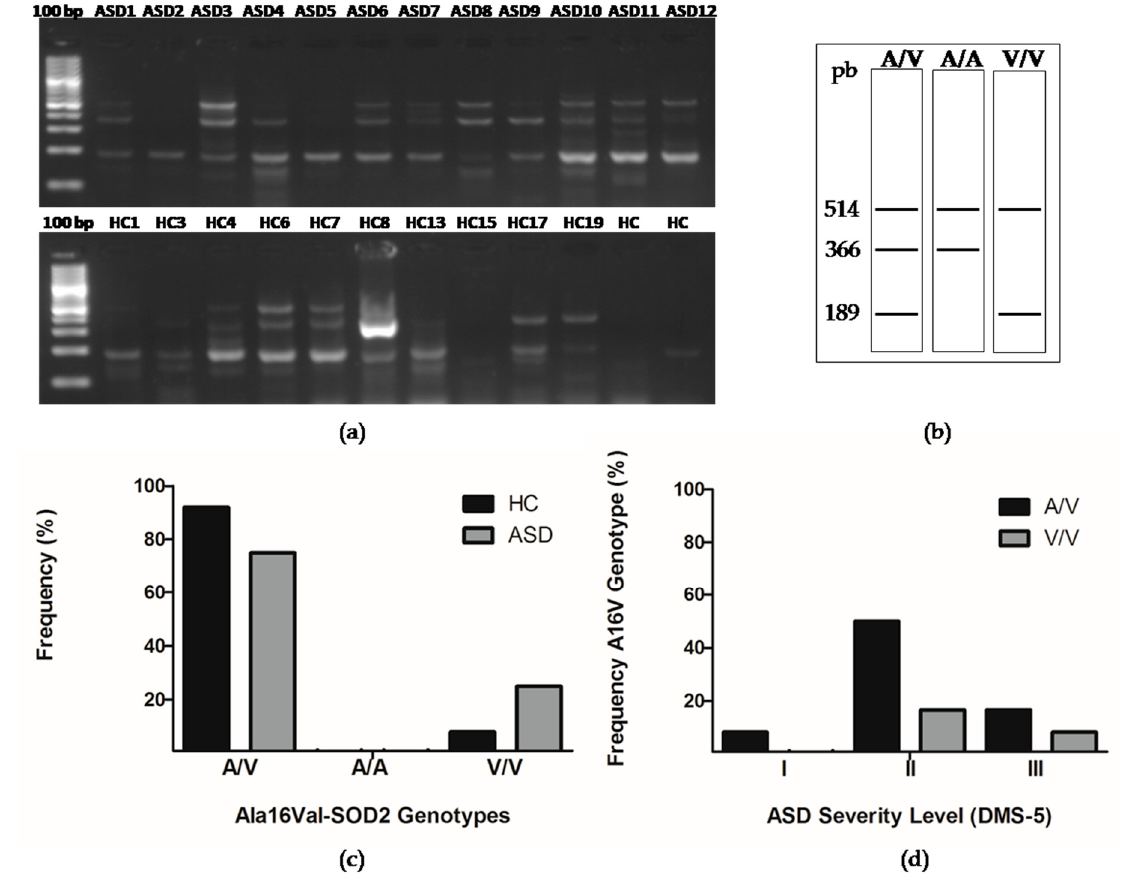
Figure 4. The presence of the Ala16val-superoxide dismutase (Ala16val-SOD2) polymorphism in Chilean children with ASD and in HCs. ( a ) Representative genotypes analyzed in an agarose gel electrophoresis. ( b ) Scheme of genotypes. ( c ) The observed genotypes were analyzed with a Chi-squared (X 2 ) test with an alpha < 0.05 statistical significance, obtaining a P value = 0.2231 n / s (non-significant). ( d ) The distribution of Ala16val-SOD2 polymorphism in the ASD severity level was analyzed with a Chi-squared (X 2 ) test with an alpha < 0.05 statistical significance, obtaining a P value = 0.1897 n / s (non-significant).